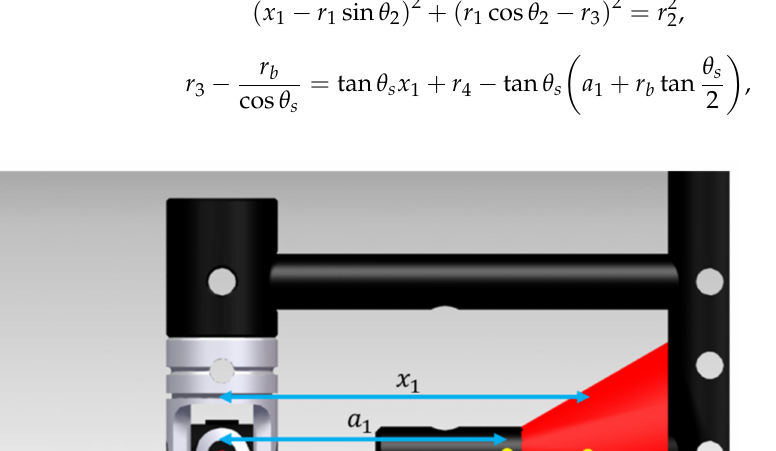
of the exoskeleton, respectively. P 1 and P (cid:48) represent the center of the ball before and after 1 hip adduction of the exoskeleton, respectively, and R 0 and R (cid:48) represent the contact point 0 between the ball and the pelvic link before and after hip adduction of the exoskeleton, respectively. θ 1 represents the angle between O 1 P 0 and the thigh link, and θ 2 represents | θ − θ | . To derive the dynamic equation of this system, x 1 1 and r 3 should first be defined. The kinematic equations are